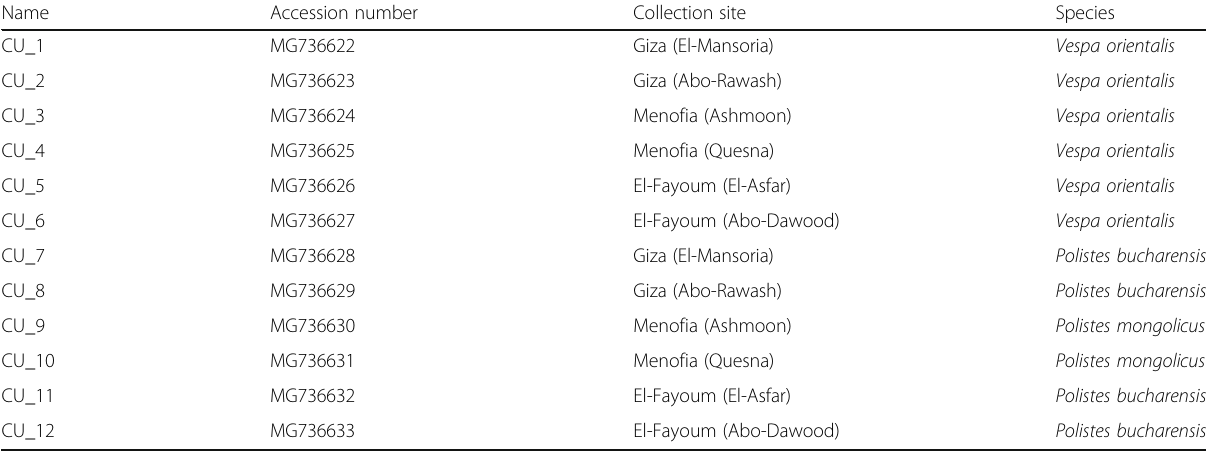
Table 1 List of species, collection sites, and GenBank accession numbers of